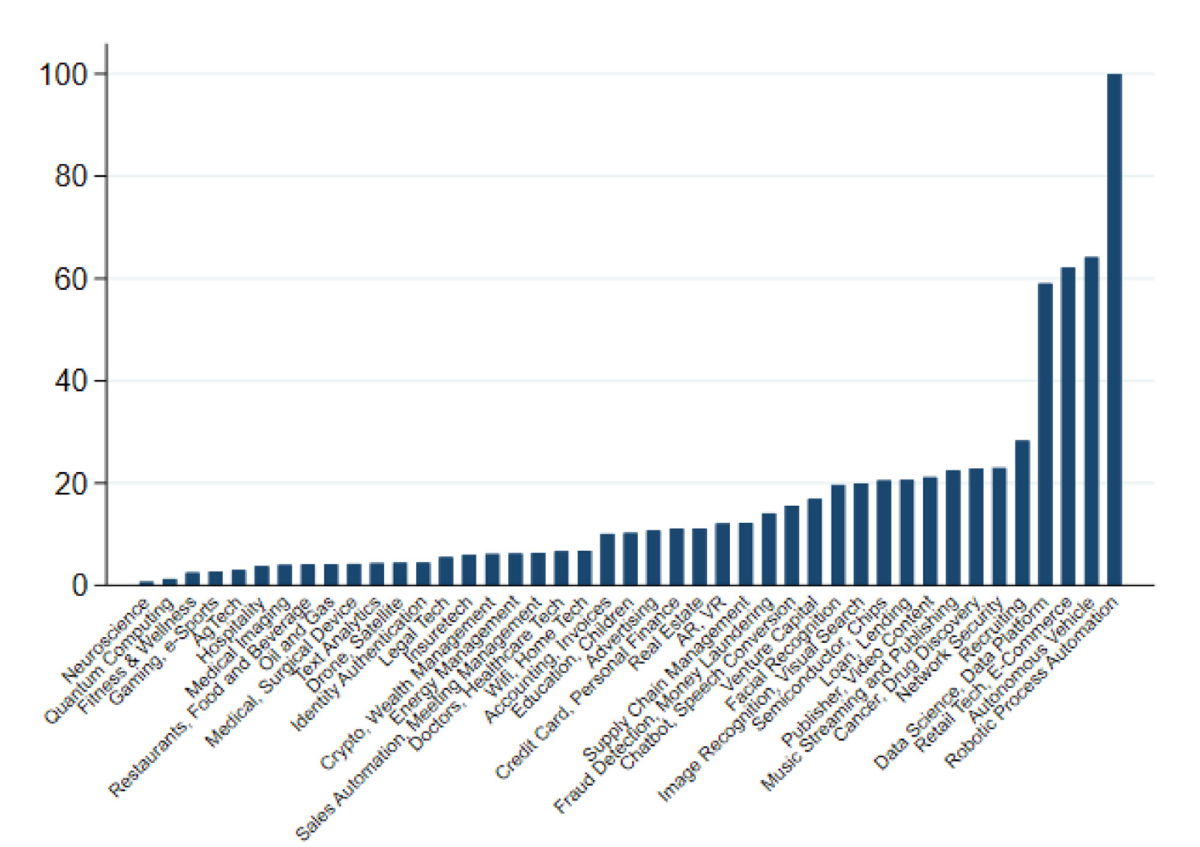
FIGURE2 Main areas of AI development (2010–2020, cumulative investment in US$, global; Robotic Process Automation = 100). The chart depicts the cumulative, global investment in US$ over the period 2010 to 2020 in various AI-applications. Investments have been scaled such that